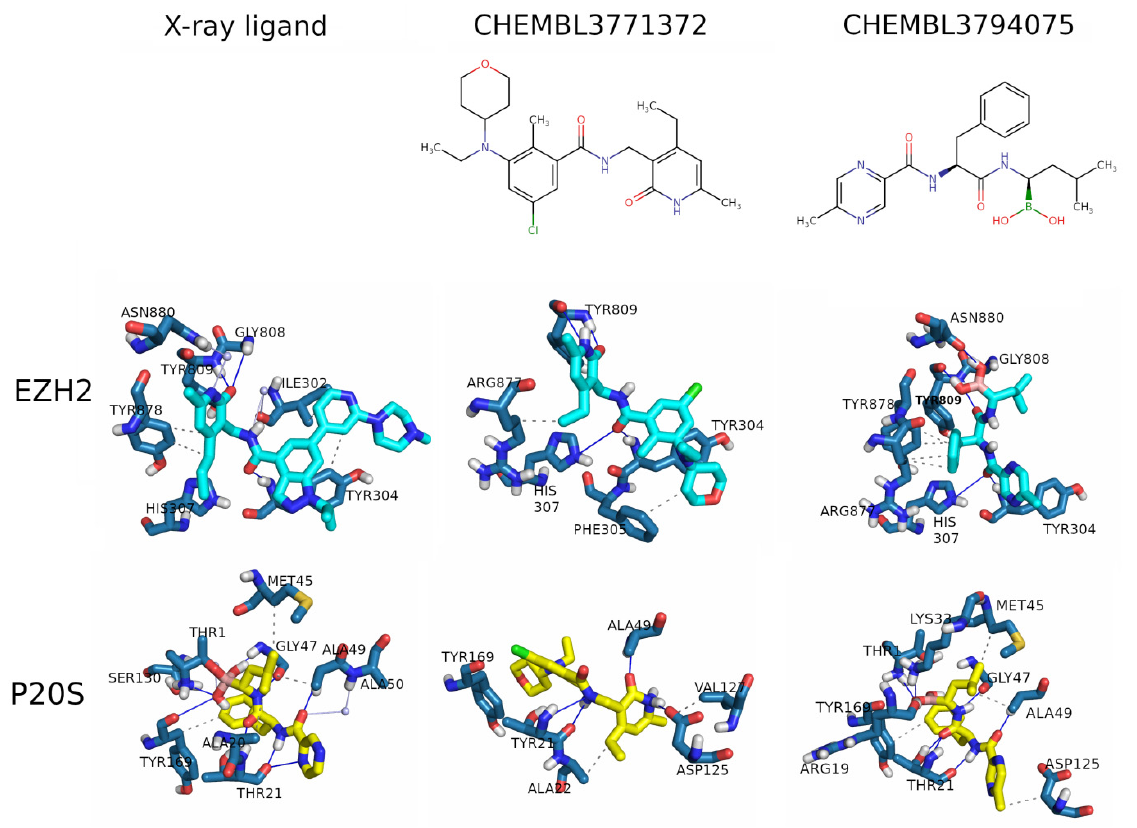
Figure 12. Representation of the 2D structure of the docking hits ( top row ), and 3D placement of the ligands (X-ray and